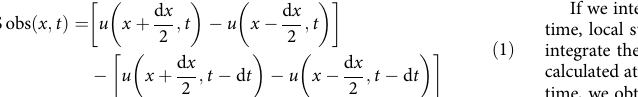
linearly related to the length of this section 27 . When the section of the sensing fi bre is unperturbed, the length and, consequently, the phase-difference Δ ϕ remains unchanged. Any perturbation inducing a strain ε on the fi bre will change that difference. The strain rate can therefore be mapped along the sensing fi bre by examining the changes in the phase of the elastically backscattered photons between successive measurements. For example, an imbalanced Mach-Zehnder interferometer has been used to measure dynamic strain changes along the fi bre 64 . A fi bre-optic cable can hence be considered a system consisting of a large number of one component relative strain gauges. State of the art DAS systems are capable of quantifying the frequency, amplitude, phase and location of dynamic perturbations anywhere along the sensing fi bre. Measurement systems with the capability to resolve perturbations of 40 n ϵ are reported 27 . Strain and displacement and velocity determination . In our study, we de fi ne the DAS system as comprising the deployed fi bre-optic cable (sensor) and the iDAS interrogation system 33 . The phase-difference is a measure of the relative travel time and hence the relative distance. The physical distance over which the phase- difference measurement is performed, is referred to as the “ gauge length ” d x 26,61 . Comparing successive pulses, phase changes are directly related to the distance changes and therefore the strain rate in direction of the fi bre can be recorded. In the iDAS system, each digital sample is indexed by the centre location of a moving window along a cable ’ s fi bre core (the sample ’ s ‘ channel ’ , x ) and recording time (the sample ’ s ‘ time ’ , t ). Thus, if u(x,t) represents the dynamic displacement of the fi bre, the DAS observation DASobs at axial location x and time t is a measure of the strain rate at the distance x from the iDAS recorder and is expressed by: d x ; t DASobs ð x ; t Þ ¼ u x þ 2